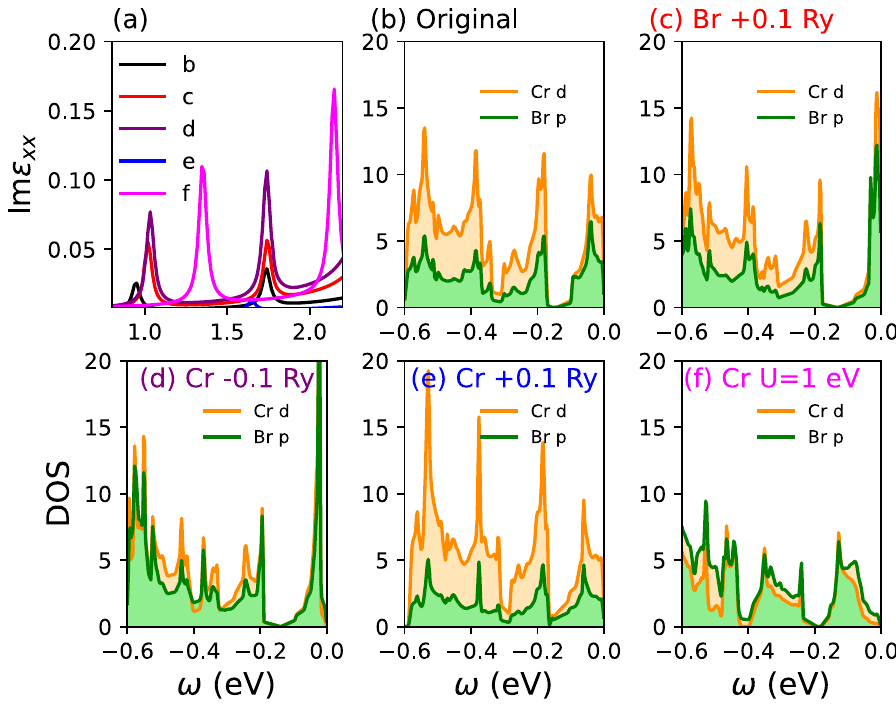
Fig. 7 Tunability of excitons in monolayer CrBr 3 by modifying dp hybridization environment. QS G b W results in different circumstances. a The Im ϵ xx is shown for different conditions from ( b – f ). b Unperturbed (original) DOS in ml-CrBr 3 . c Br + 0.1 Ry shifts the Br- p center of mass up by 0.1 Ry, ( d ) Cr − 0.1 Ry and ( e ) Cr + 0.1 Ry down/up shifts Cr- d the center of mass by 0.1 Ry and CrU = 1 eV adds U = 1 eV Cr- d . In cases with larger Cr- d and Br- p hybridization the excitons become more intense and get blue-shifted and the reverse happens for lesser hybridization. However, the position of ex 1,2 changes dramatically for ( f ) CrU = 1